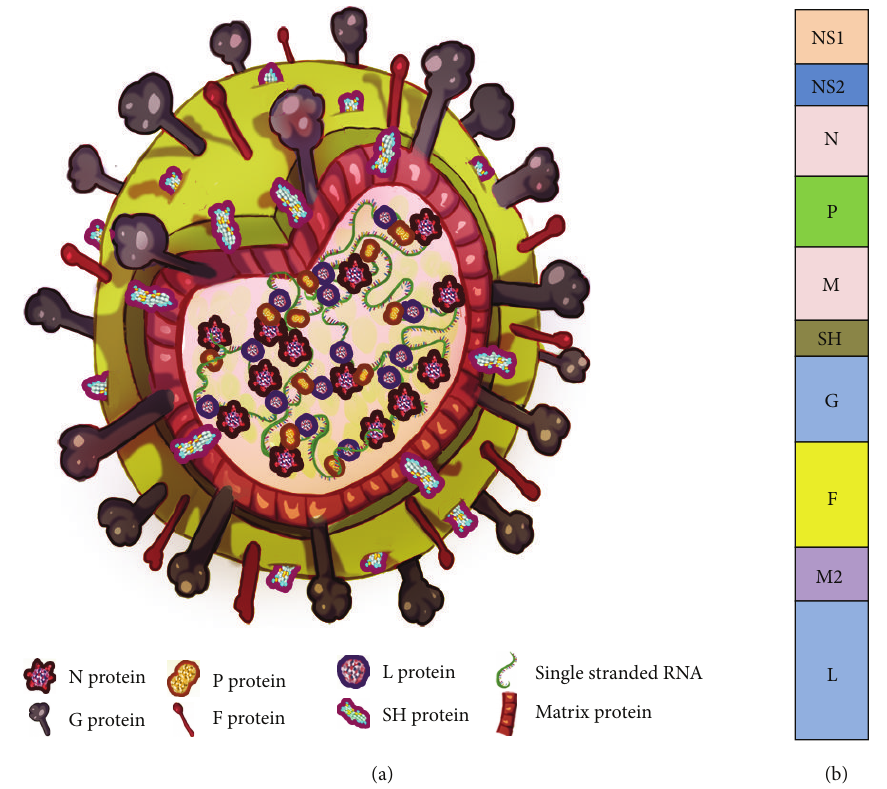
Figure 1: Structure and genome organization of respiratory syncytial virus. (a) Approximately 200 nm RSV virion particle and (b) single stranded negative RNA genome consisting of 10